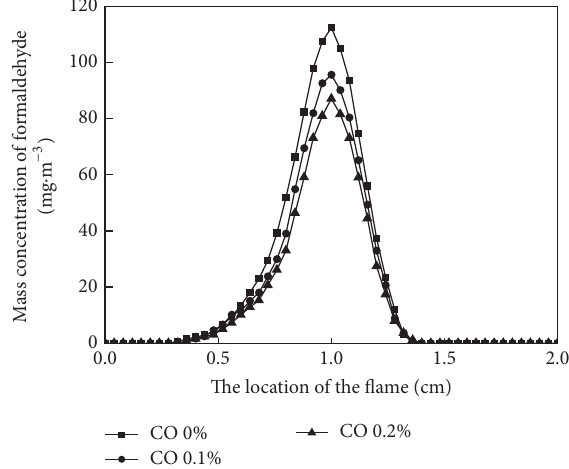
Figure8:InfluenceoftheadditionofCOonformaldehydeemission for biodiesel.